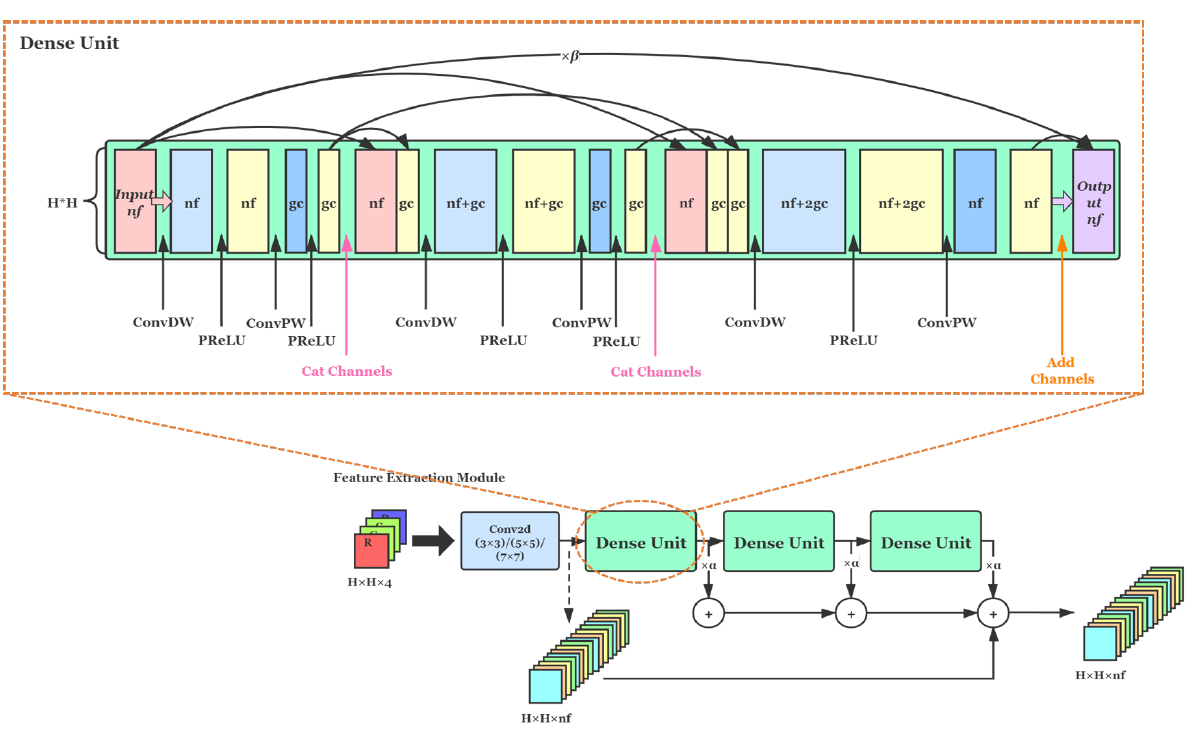
Figure 3. The first two cross-layer connections in each Dense Unit are connected between channels, while the cross-layer connection before the final output is summed by the feature map values. Since a normal dense block is composed of a large number of ordinary convolutions, the number of parameters could be large. Therefore, all the convolutions in our densely connected layers use depthwise separable convolutions [40], which further reduces the number of parameters of the network.